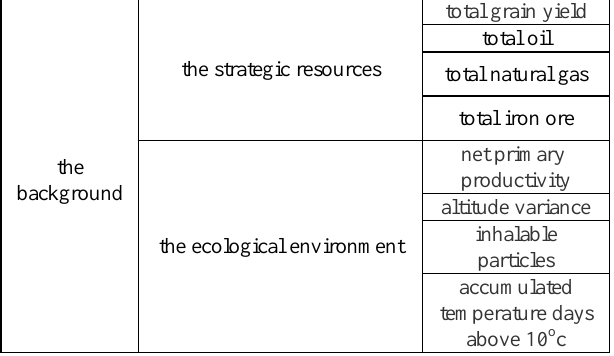
Table1. The background indicator